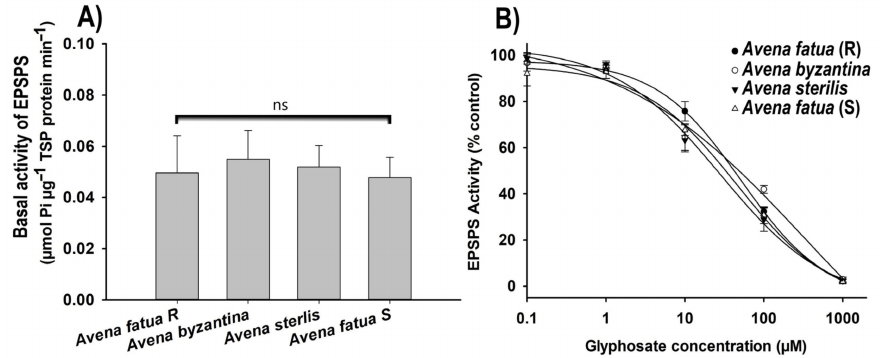
Figure 8. ( A ) Basal activity of 5-enolpyruvilshikimato-3-phosphate synthase (EPSPS) in the absence of herbicide of four Avena accessions. ( B ) Glyphosate concentration necessary to inhibit EPSPS activity at 50%. (R) = resistant; (S) = susceptible; ns = non-significant. Bars in plots represent the standard error of the mean ( n = 6). Table 3. Parameter values and resistance index of the log-logistic function used to model enzyme